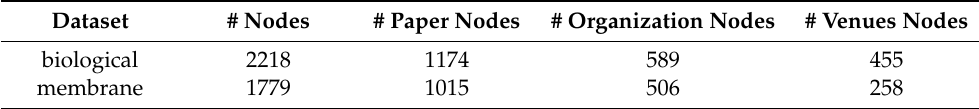
Table 1. Statistics of nodes in heterogeneous networks of the biological computing and membrane computing datasets.